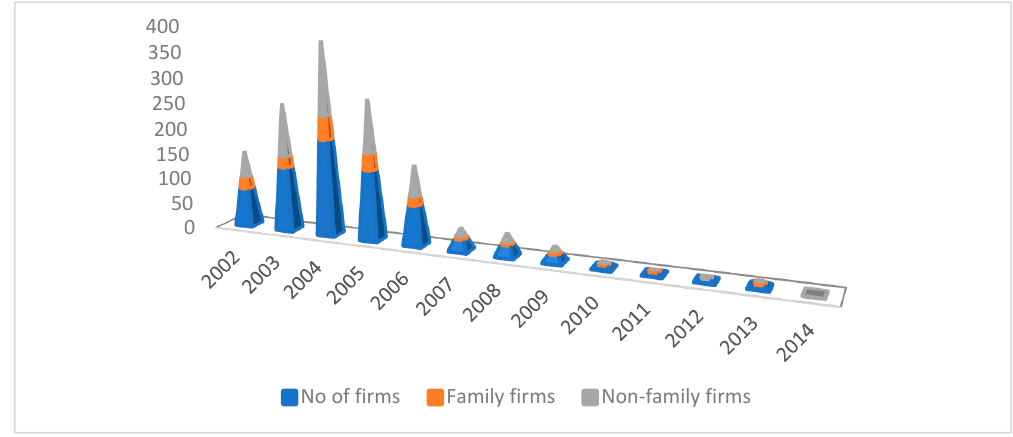
Figure 1. Number of Bankrupt firms over the period 2002–2014. Source: Authors’ elaboration.